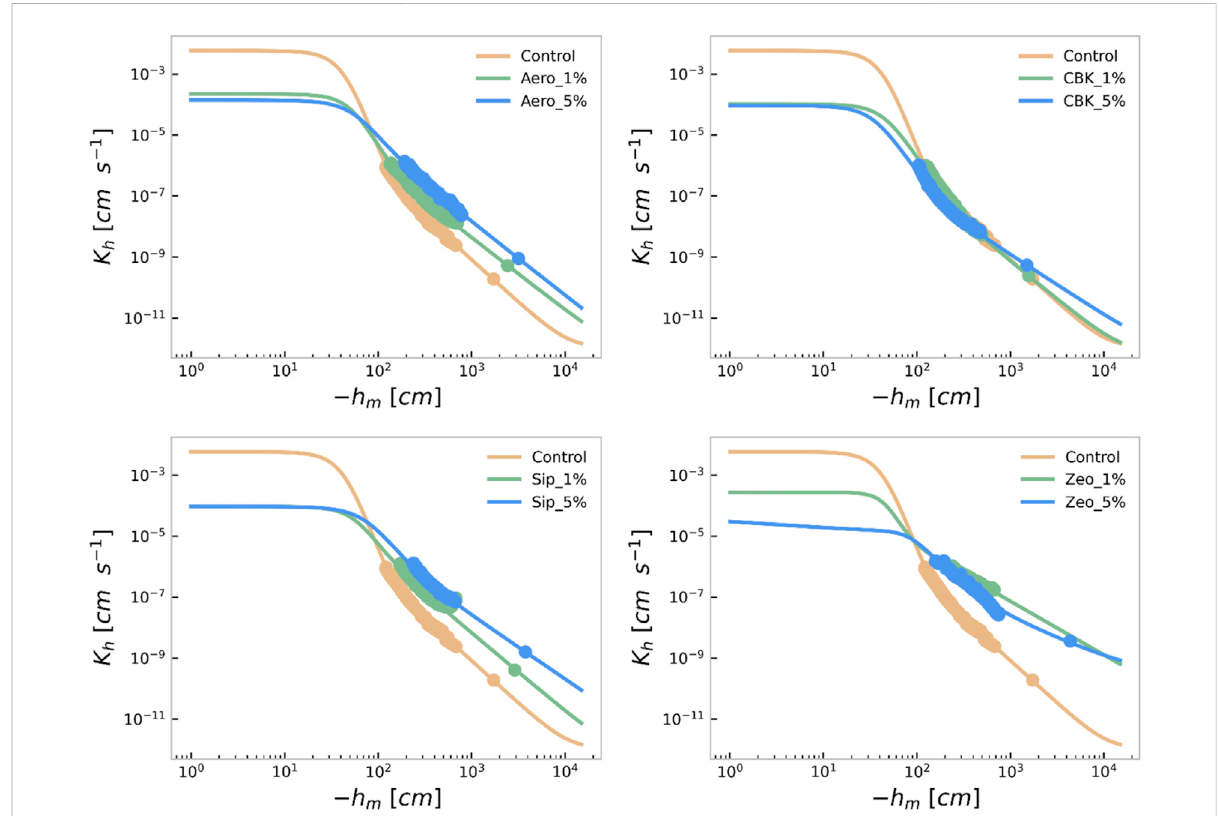
FIGURE 3 Different ASi amendments reduced the hydraulic conductivity of soils at near-saturated conditions, but it maintained a higher hydraulic conductivity as soil dried in sandy soil and pure quartz sand (Supplementary Figure S3 as supplementary information). The dots are the measured hydraulic conductivity curves, and the lines are the estimated curves based on the PDI model.